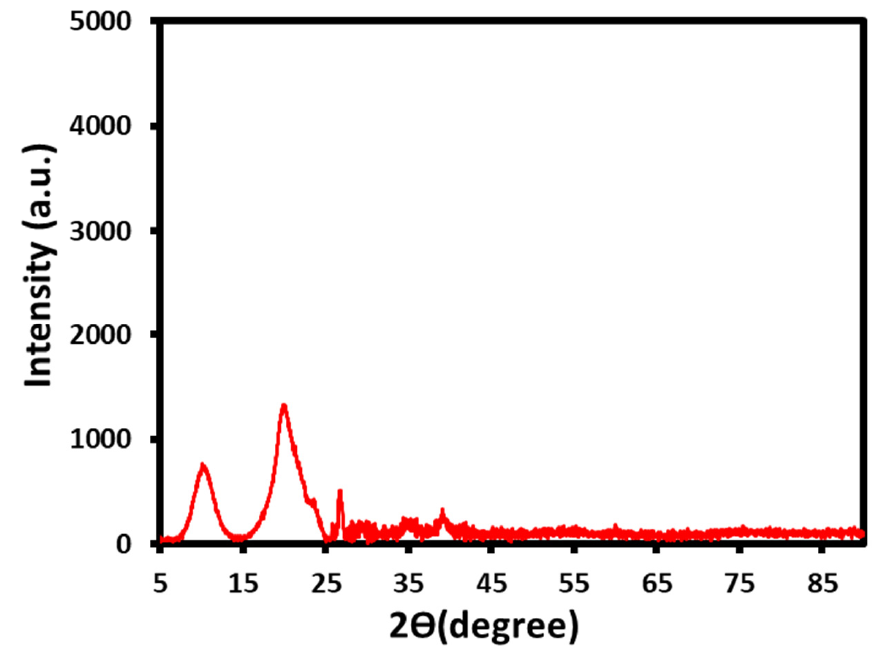
Figure 6. XRD analysis of